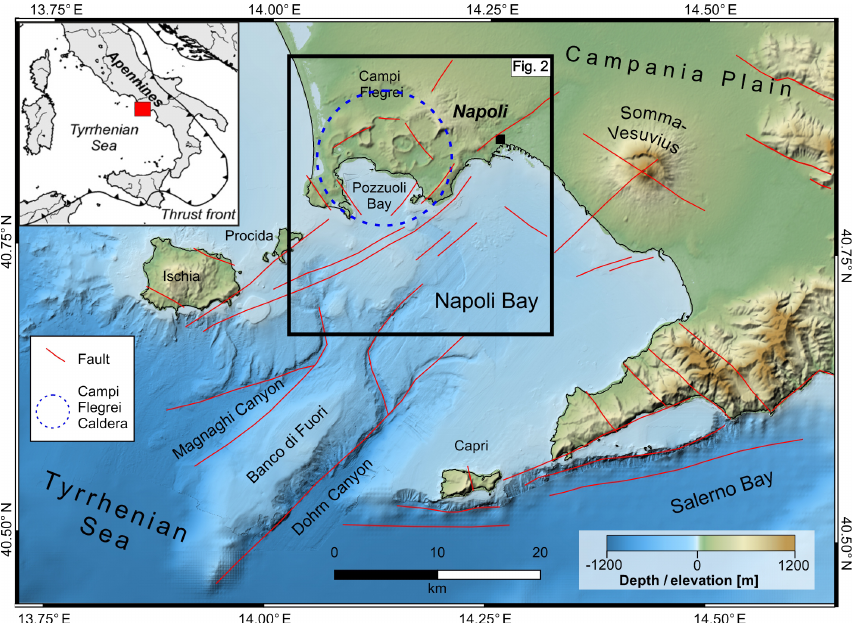
Figure 1. Tectonic sketch map of the Campanian continental margin in SW Italy with the location of the Campanian volcanic zone. Frame of Fig. 2 is also